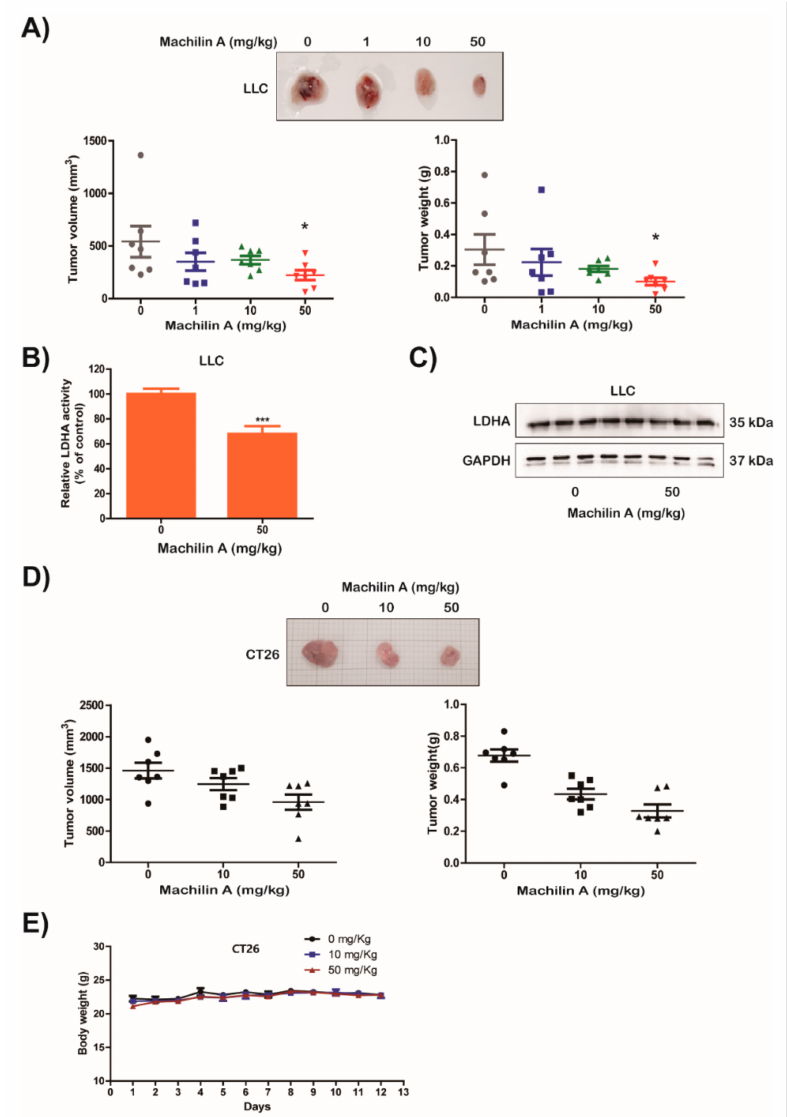
Figure 4. Suppression of tumor growth by machilin A in mice inoculated with lung and colon cancer cells. LLC and CT26 cells were inoculated subcutaneously on the back of C57BL / 6 mice and BALB / c mice. After inoculation, the mice were intraperitoneally injected with the indicated dosages of machilin A on a daily basis. Mice were sacrificed 21 days after inoculation. ( A , D ) Photographs of each tumor treated with the indicated dose of machilin A are shown. Volume and weight of each tumor was measured. Data are presented as means ± SD. Statistic tests were performed using a Student’s t-test. * p < 0.05 compared to the control. Cancer tissues harvested from mice were lysed. ( B ) Lactate dehydrogenase A (LDHA) activity was analyzed. Data are presented as means ± SD. Statistic tests were performed using a Student’s t-test. *** p < 0.001 compared to the control. ( C ) The expression of LDHA was examined using a western blot analysis. GAPDH expression was used as an internal control. Data are shown after a densitometric analysis. ( E ) Body weight of each mouse was measured daily during injection of machilin